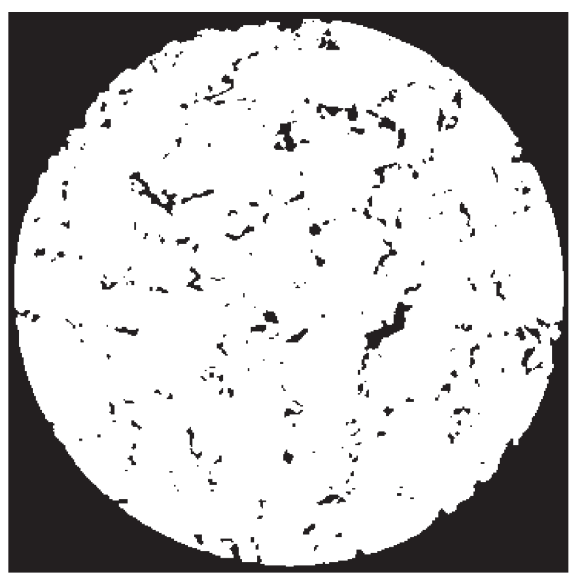
Figure 10: Void picture after